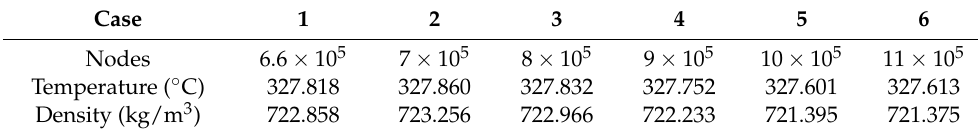
Table 6. Properties variation at the outlet as the number of nodes increases.